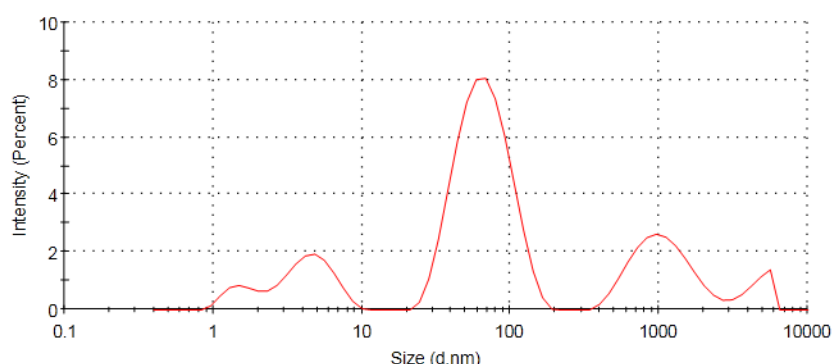
Figure 8. Dynamic light scattering of the biogenic AgNPs synthesized using aqueous peel extract of Punica granatum .